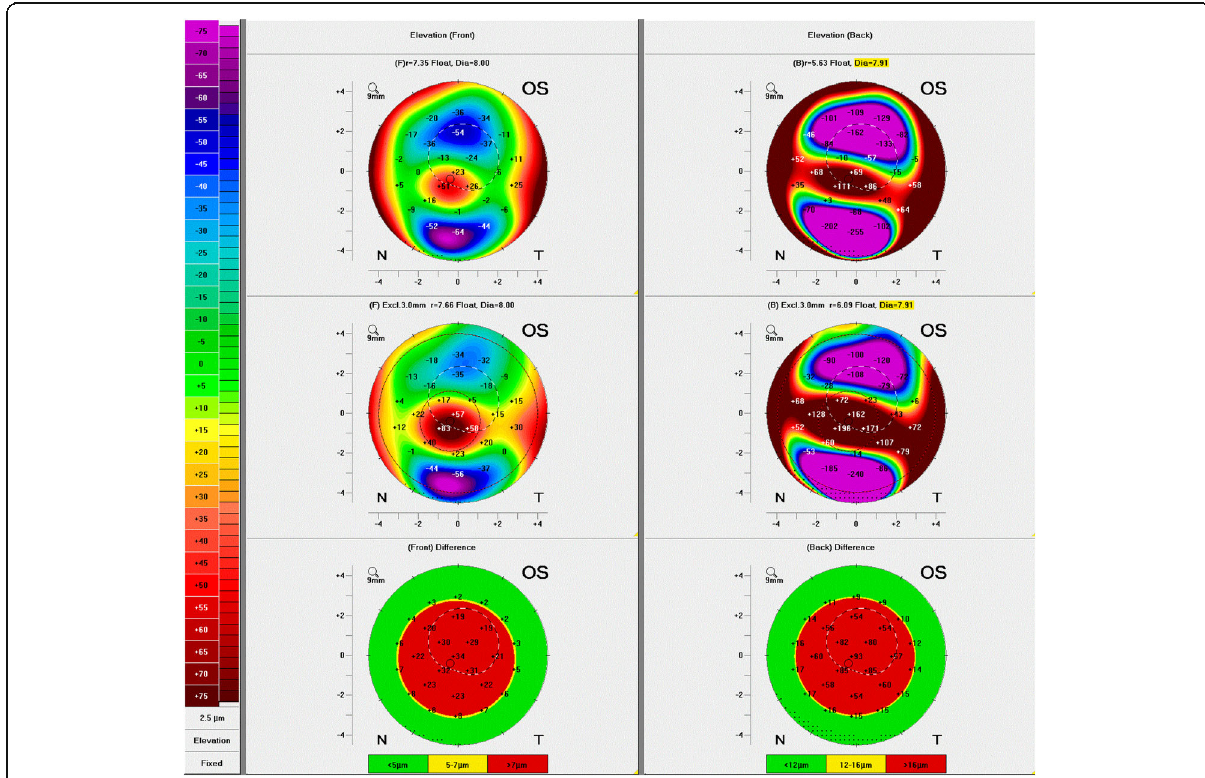
Fig. 4 Elevation maps of the anterior (left) and posterior surface (right) of the left eye before corneal